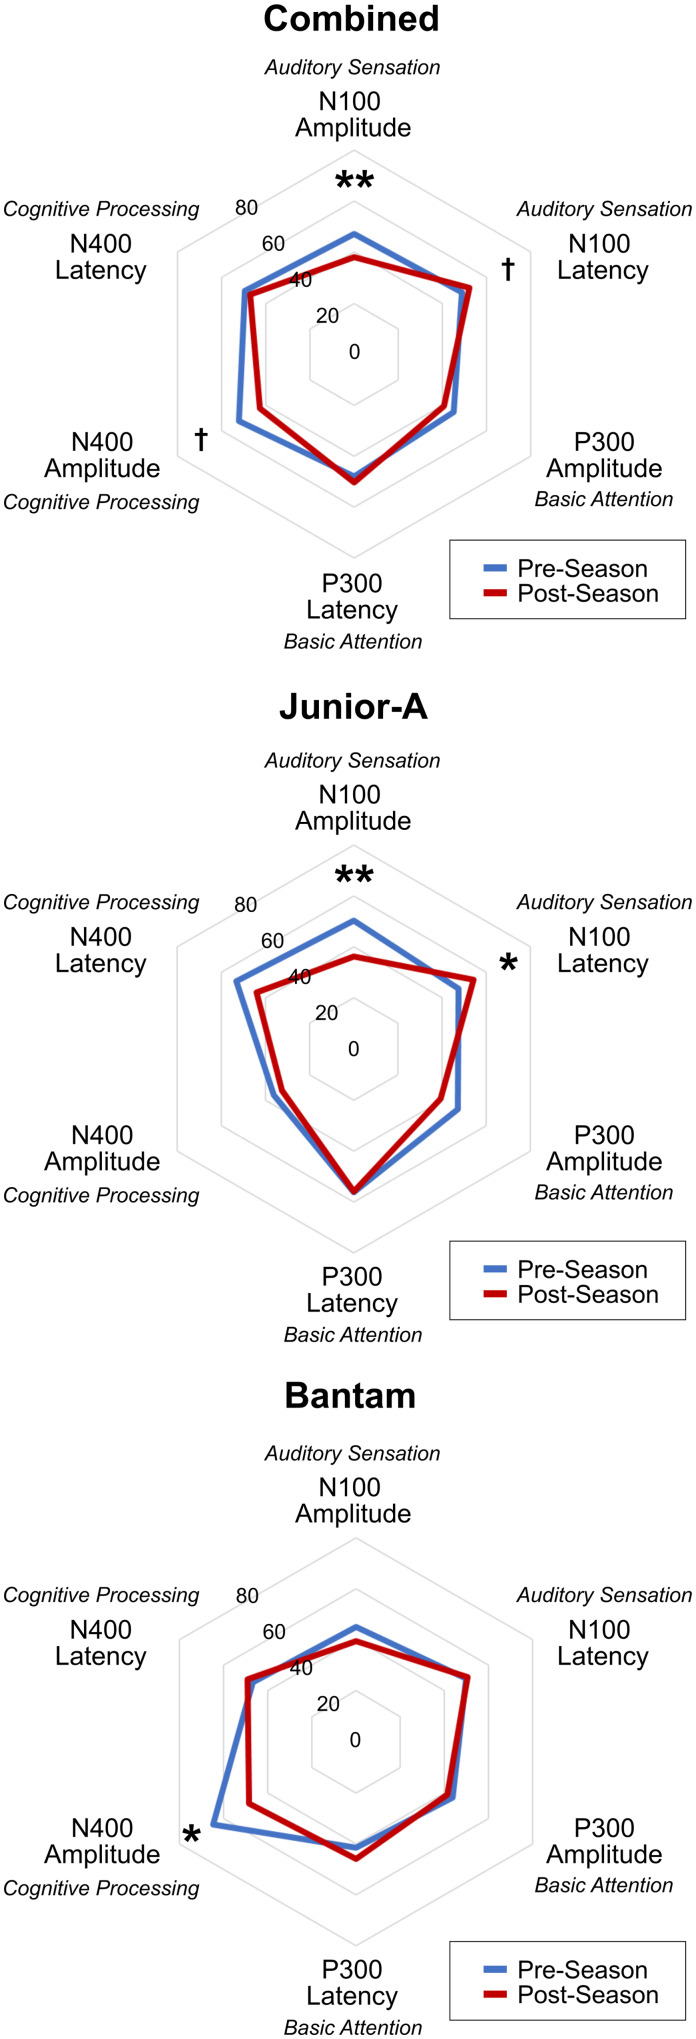

Radar plots. Radar plots showing group brain vital signs profile trends from pre-season to post-season, in both groups (top), Junior-A only (middle) and Bantam only (bottom). The combined plot is included to demonstrate the changes across both age groups (N = 37). **P < 0.01; *P < 0.05; †P < 0.056